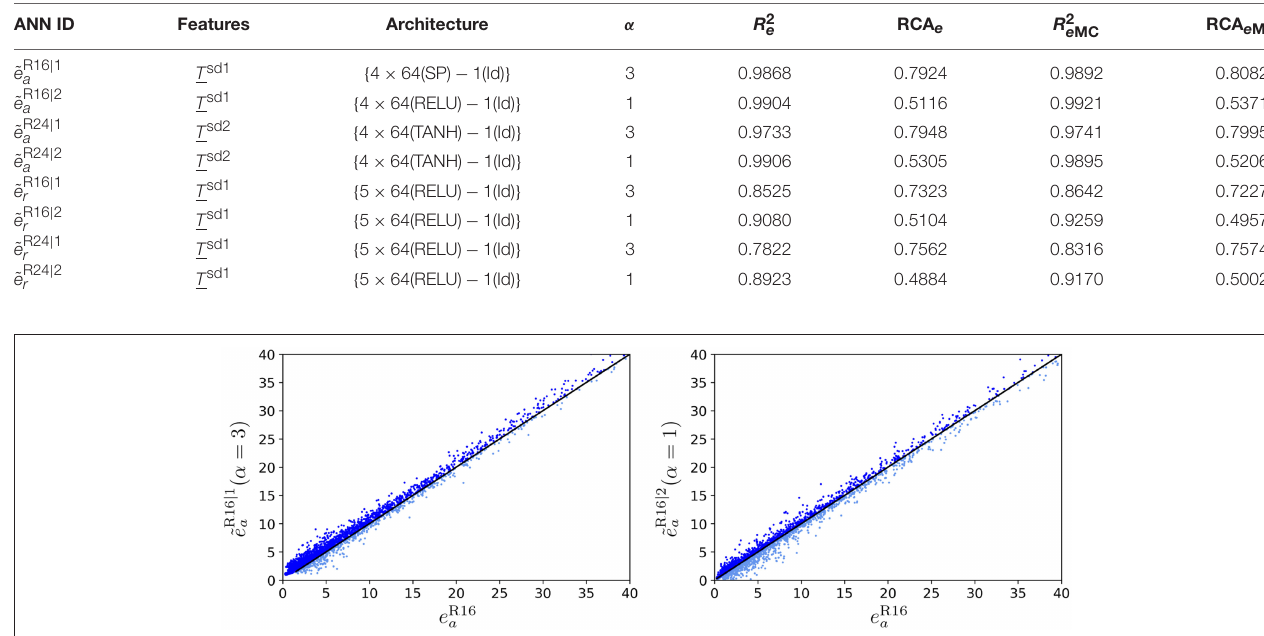
FIGURE 6 | Correlation plots for the ROM16 ANE and corresponding error regression ANNs in the range [0,40] MPa: ˜ e R16 | 1 a with penalization of error underestimation parameter α = 3 (Left) and ˜ e R16 | 2 a with α = 1 (Right) .